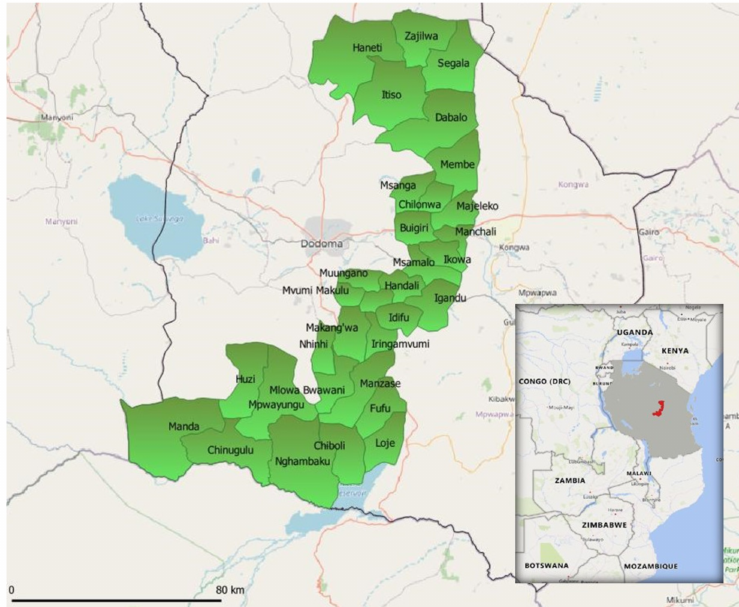
Figure 3. Chamwino District and wards in the Dodoma Region